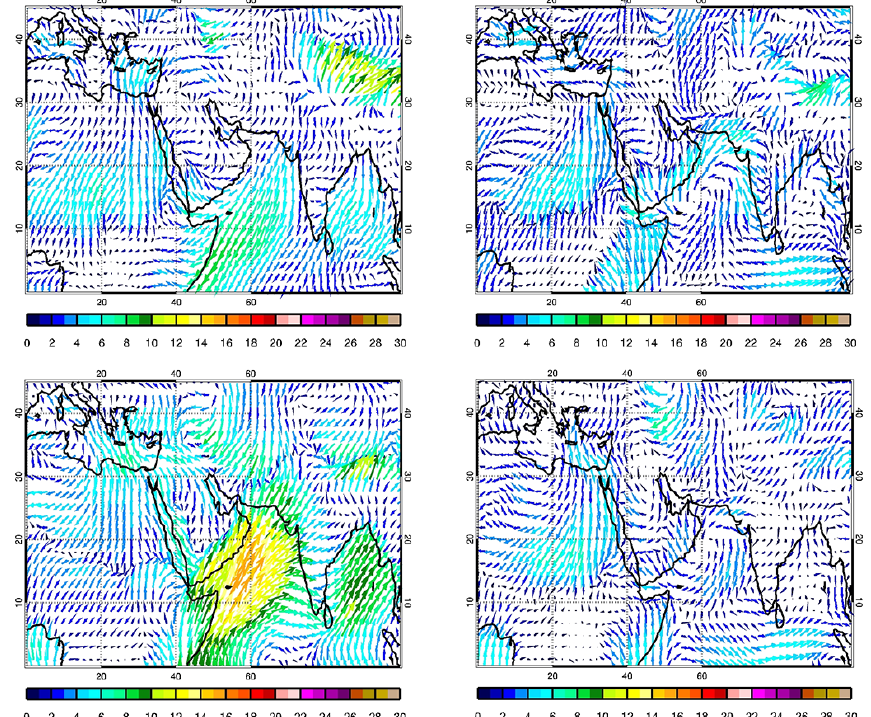
Figure 5. Ten-metre sea surface wind on January (upper left), April (upper right), July (lower left) and October (lower right) over AS at 2008 from NCEP (National Centers for Environmental Prediction). Figure provided by Anne Blechschmidt from the University of